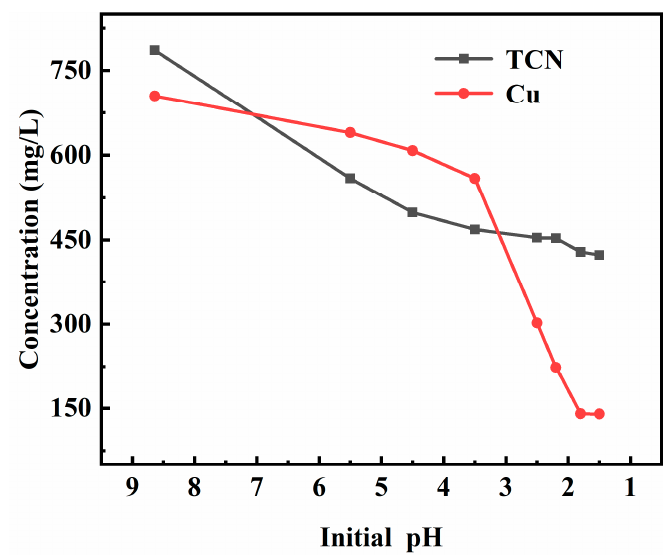
Figure 7. Effect of initial pH value of the acidification reaction on the copper precipitation effect.